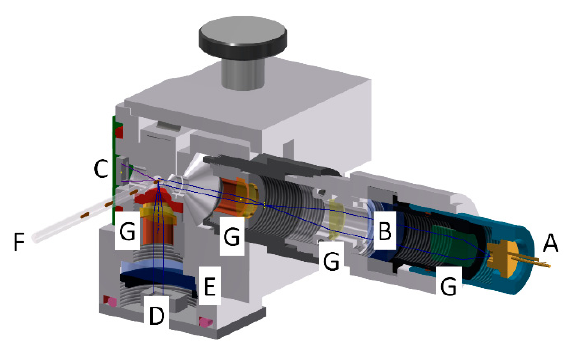
Figure 7. Schematic view on the photo-fluorimeter core unit. The design allows the simultaneous recording of absorbance and fluorescence signals from a passing droplet. (A) Excitation laser diode; (B) fluorescence excitation filter; (C) photodiode for absorbance measurement; (D) Photosensor (avalanche diode) for the detection of fluorescence light; (E) fluorescence emission filter; (F) FEP-tube for guiding the droplet sequences; (G) optical beam forming elements. The excitation wavelength of the laser diode (A) and filters (B + E) must be adapted to the desired fluorescence wavelength.